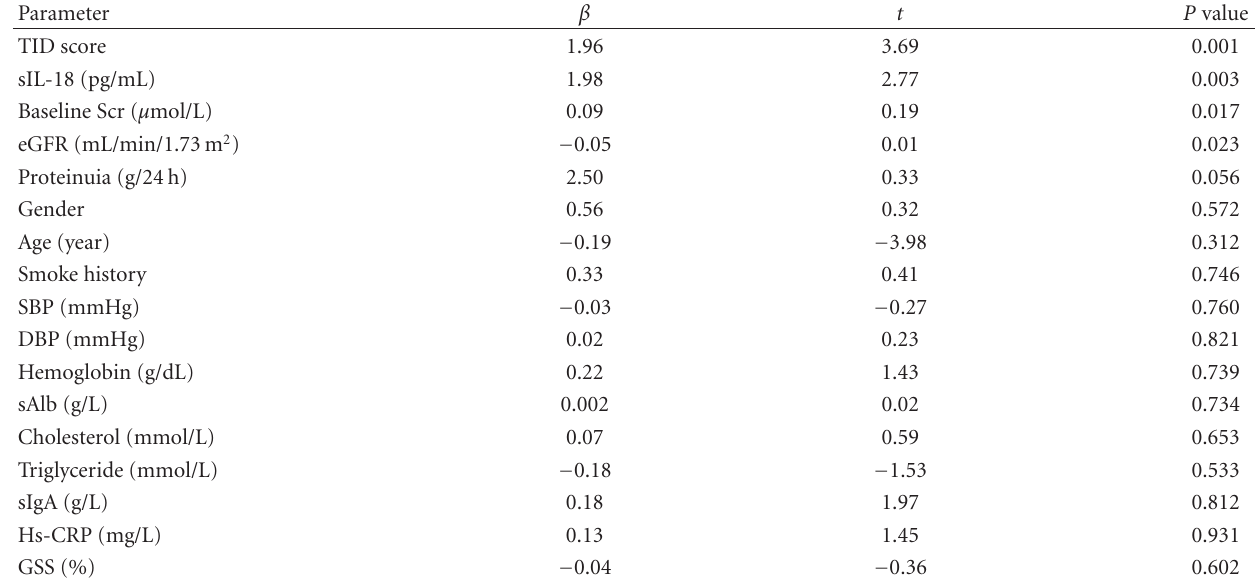
Table 6: Cox Regression analysis using to evaluate risk factor for renal function deterioration in patients with IgA